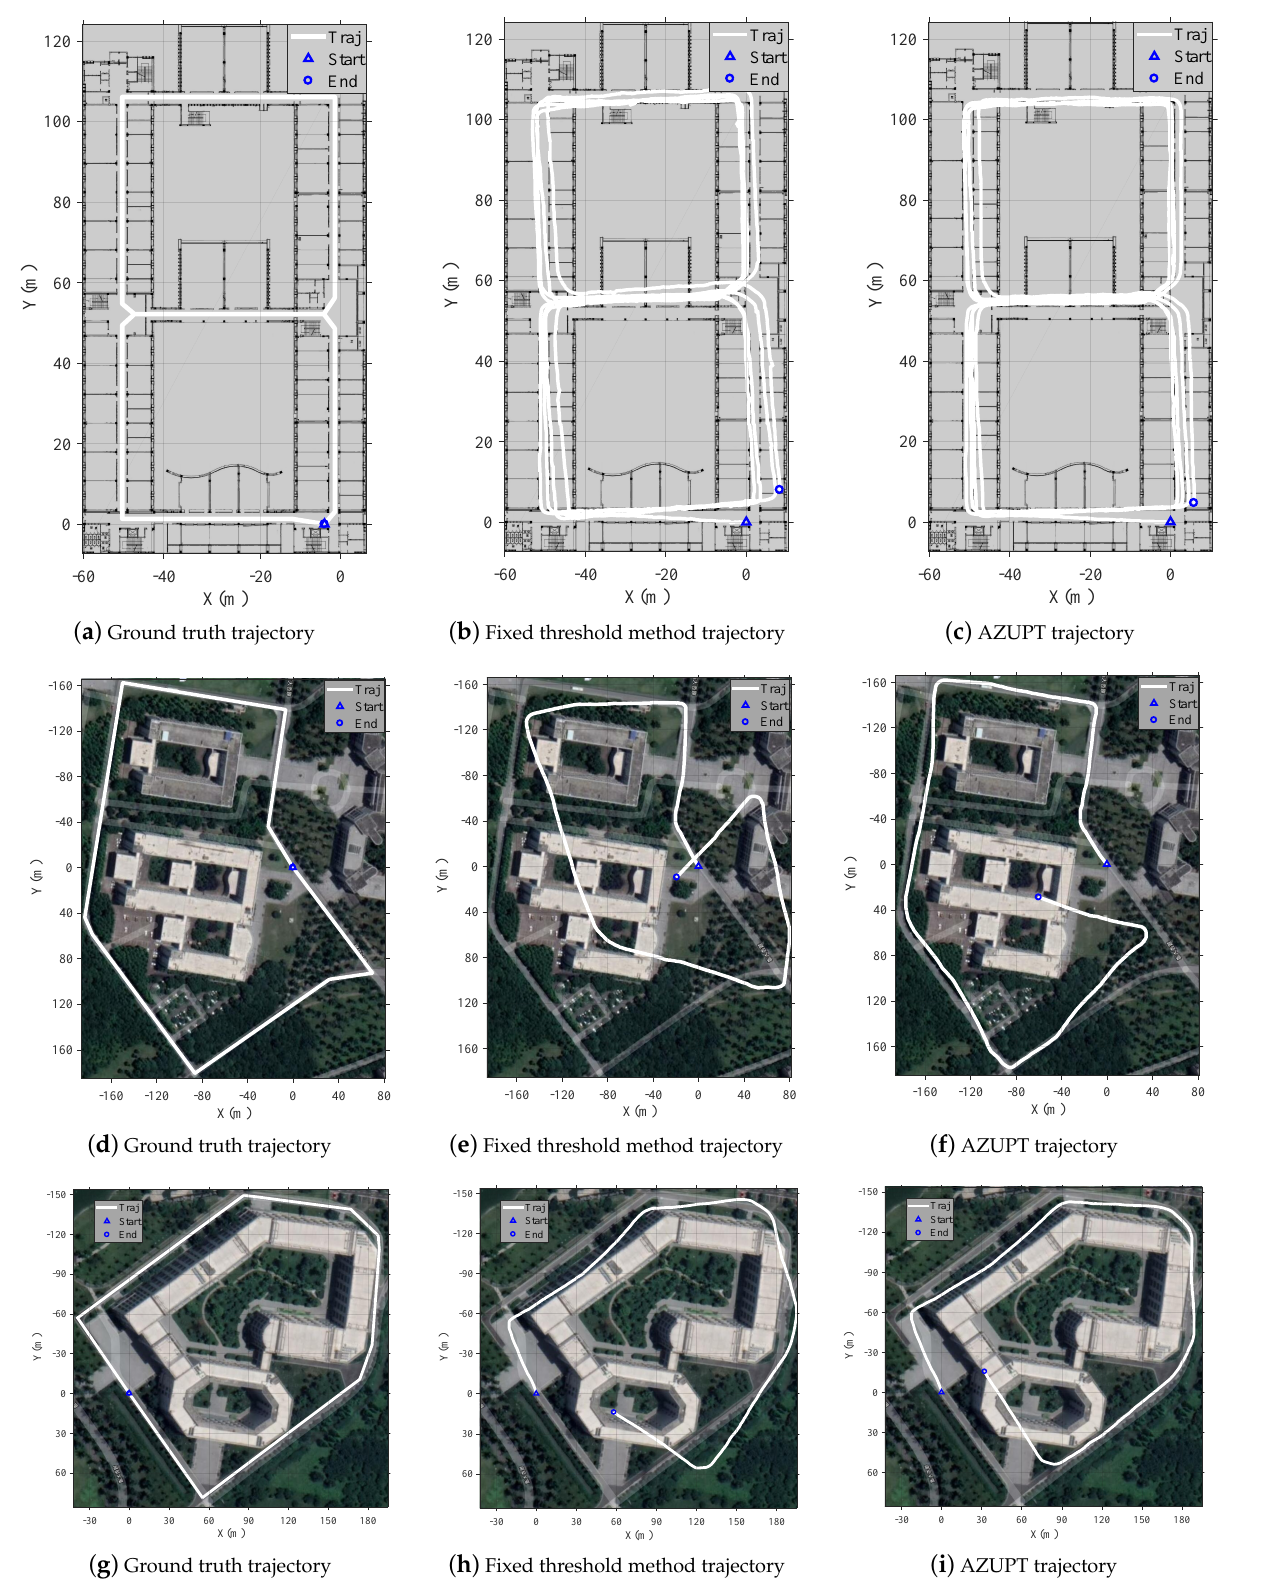
Figure 12. Experiments in the experiment building (top, walking), the scientific research building (middle, fast walking), and the first teaching building (bottom, running), showing the ground truth, fixed threshold method, and AZUPT trajectories. The fixed threshold method had a different result for different motion types and performed badly. However, the AZUPT method consistently outperformed the fixed threshold method and fit well with any of three different motion